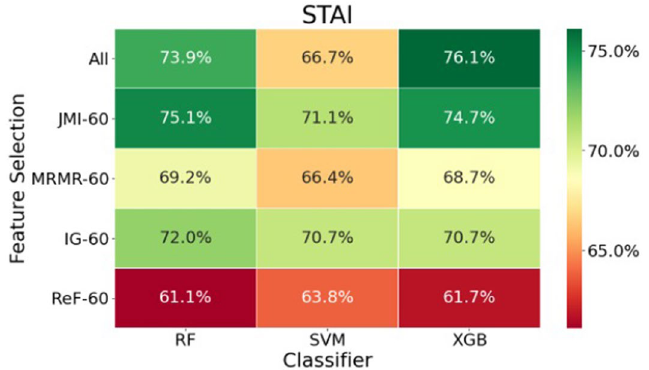
Figure 1. Heat map of prediction accuracy for feature selection and classifier methods. Our analyses yielded up to 26% higher prediction accuracy than baseline (50%) on a balanced data